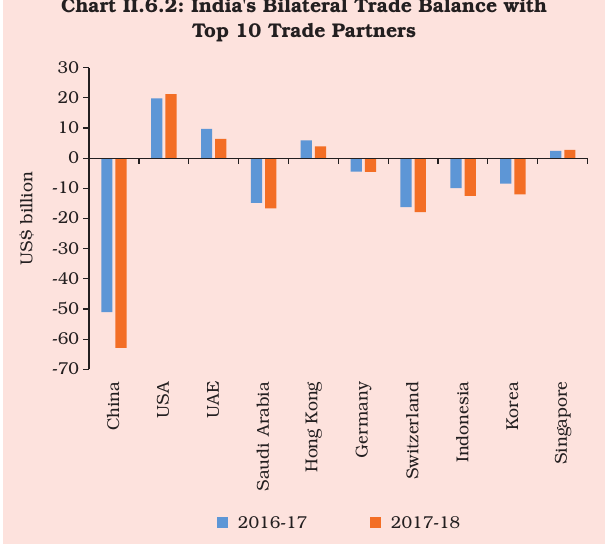
Source: Ministry of Commerce and